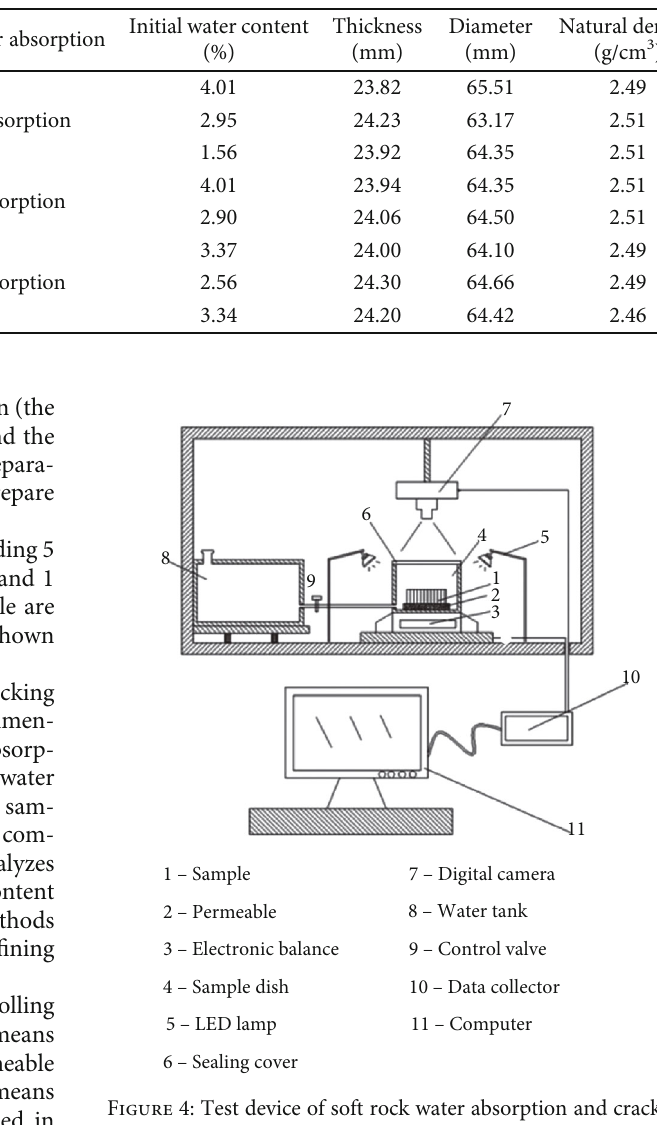
Table 2: Basic physical properties of